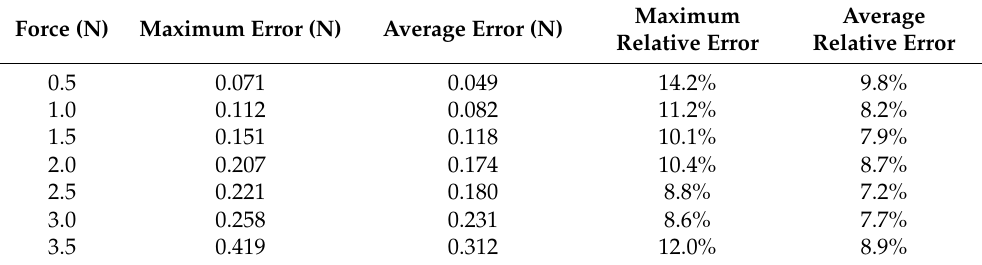
Table 1. Static force measurement results using force compensation.